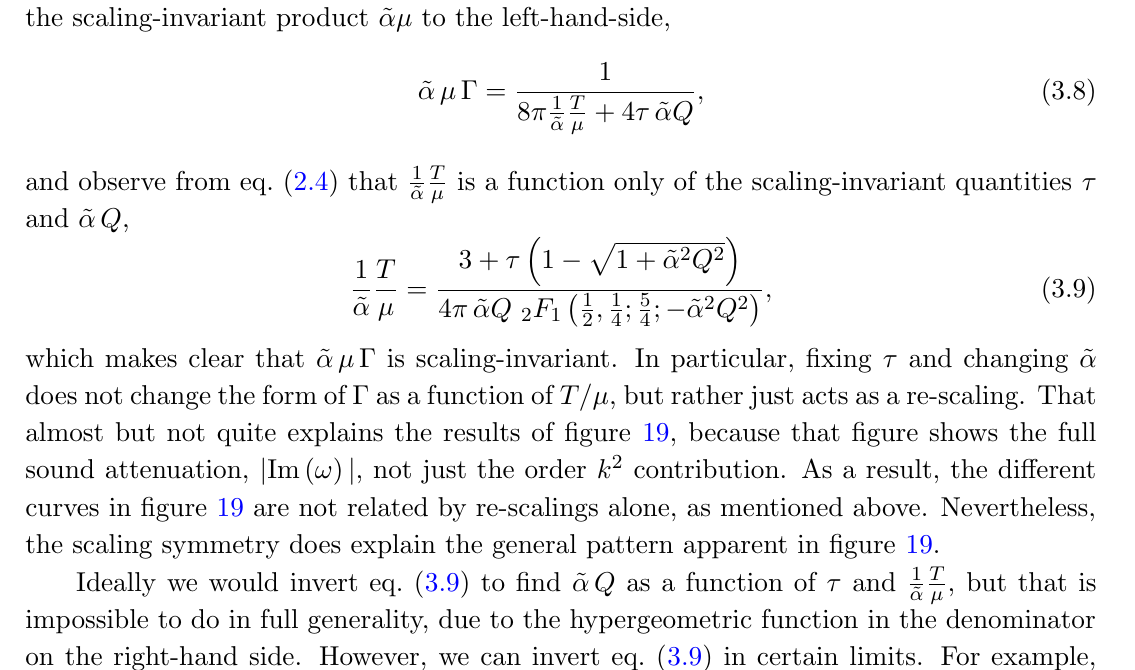
(cid:17) . Clearly our numerical results for (cid:0) 2 " + P